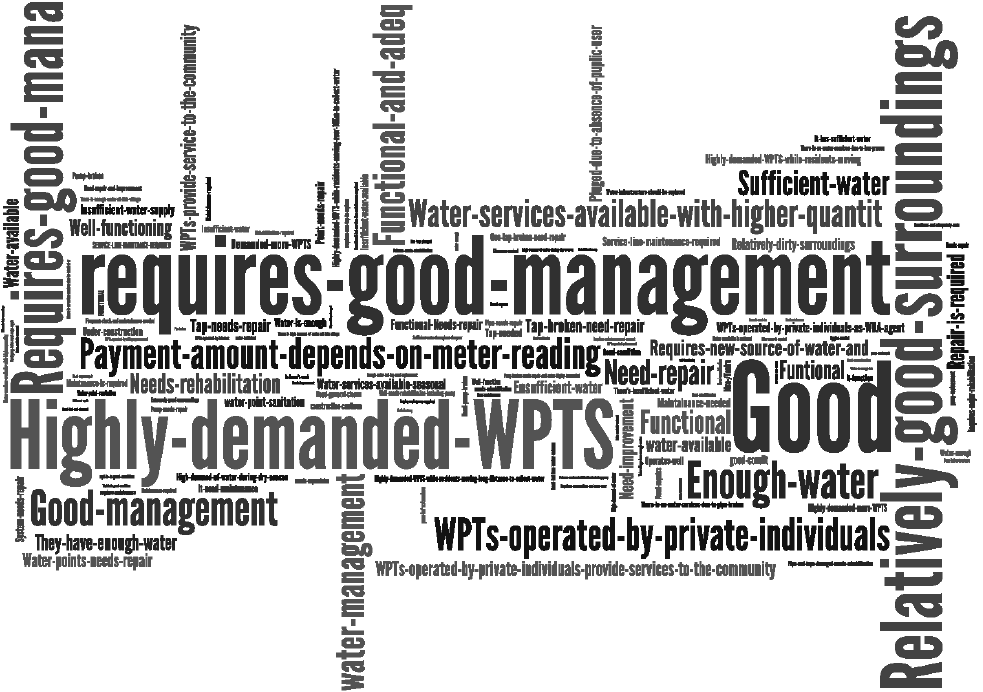
Figure 1. Word-cloud of the APR.2013 water point data constructed from 47,903 general comments. The comments were not corrected for spelling errors or variations.